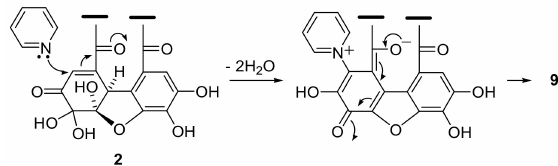
Figure 7. Products obtained by treatment of 2 with pyridine in CH 3 CN (80 ◦ C, 90 min) and HMBC correlations of 9